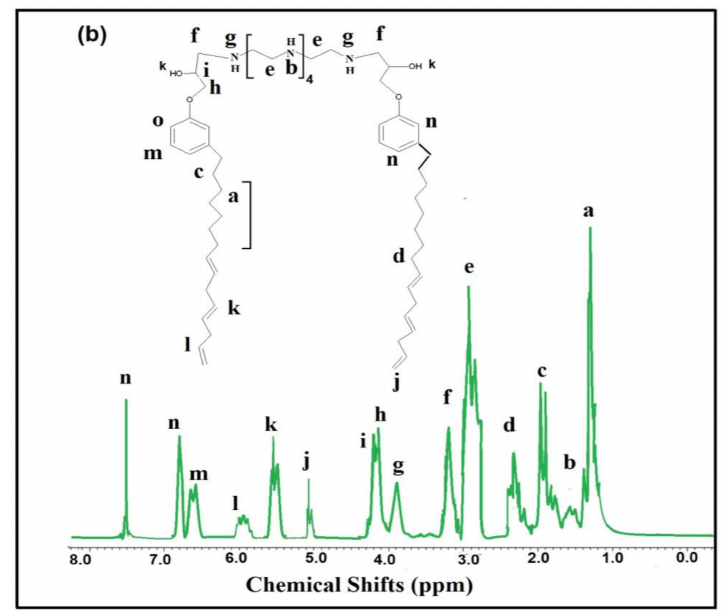
Figure 2. Nuclear magnetic resonance ( 1 H-NMR) spectra of ( a ) HPHI and ( b ) DCHI.